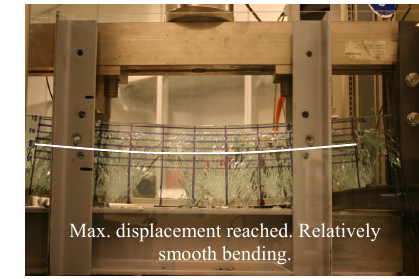
Figure 5: Plastic hinge determines 2 nd LTM in GB368 bonded reinforced glass beams. Maximum theoretical capacity is 3.59 kNm.